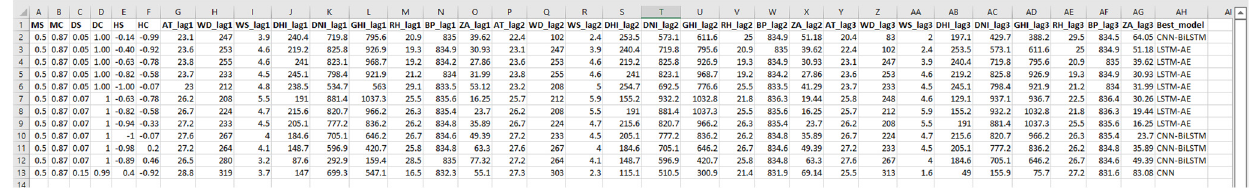
Figure 10. Snapshot of data inputs of Best Forecaster Recommendation model.